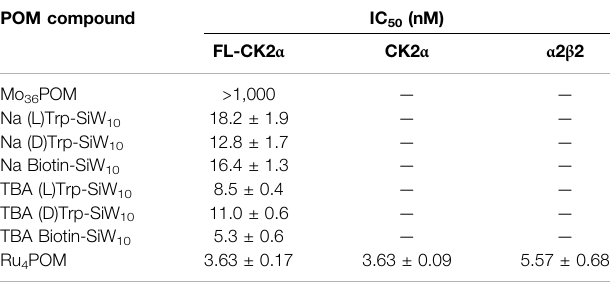
TABLE 1 | Inhibitory activity of different